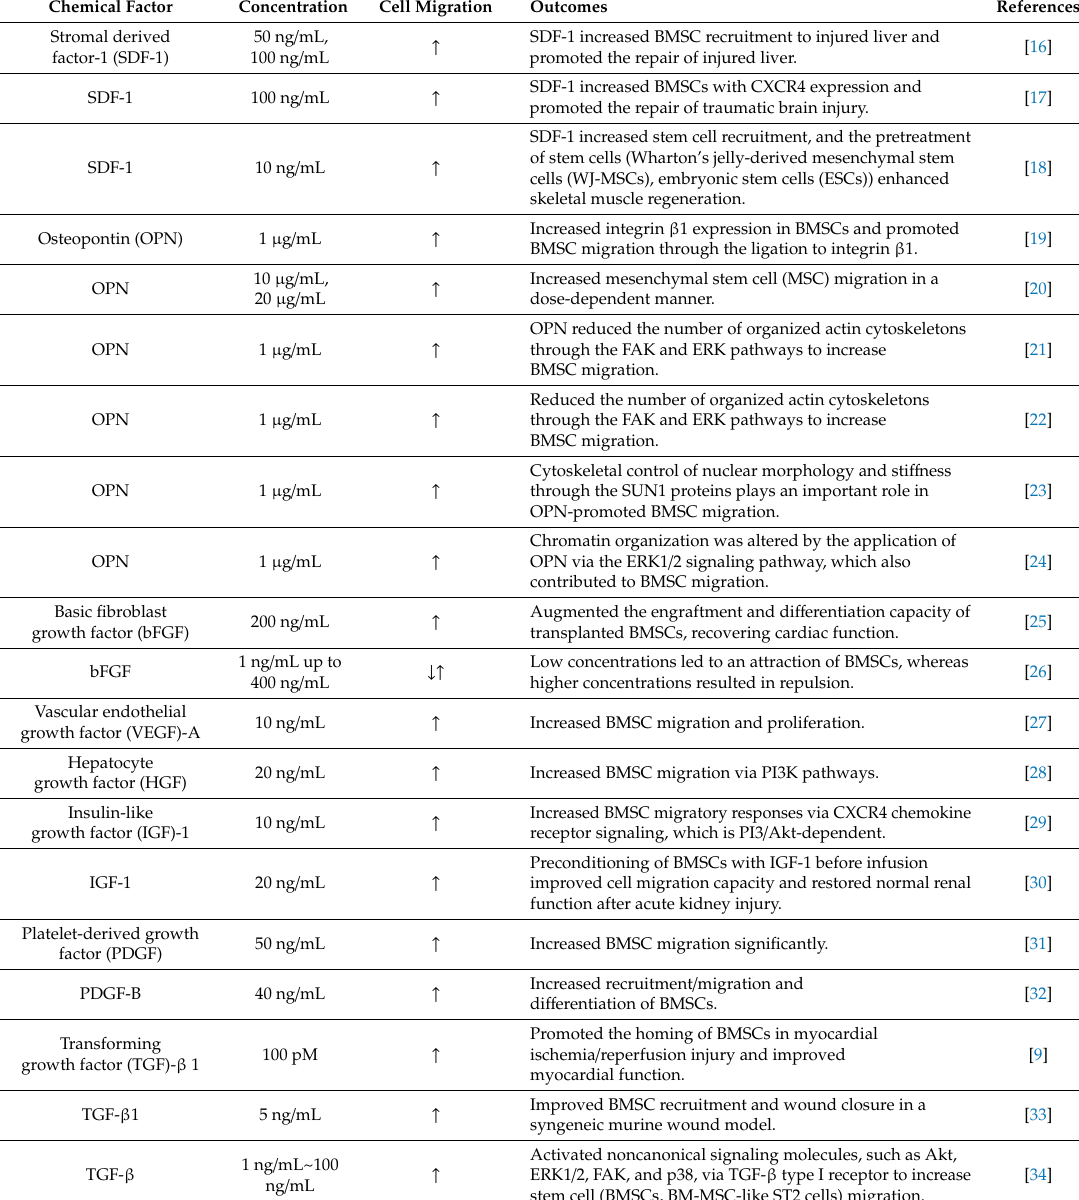
Table 1. E ff ects of chemical factors on bone marrow-derived mesenchymal stem cell (BMSC) migration Chemical